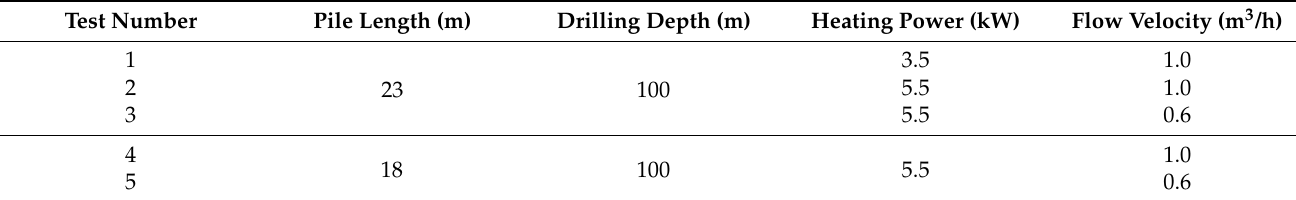
Table 1. Field test plan for heat exchange of energy